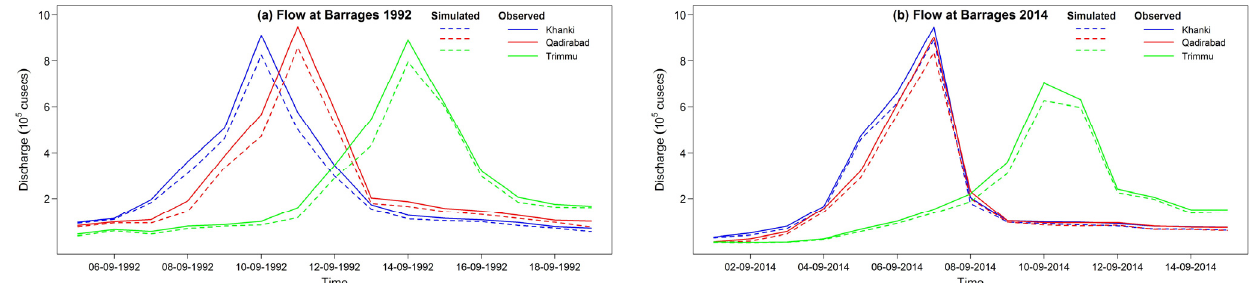
Figure 8. ( a , b ) Simulated and observed hydrographs at barrages for calibration ( a ) and validation ( b ) periods.